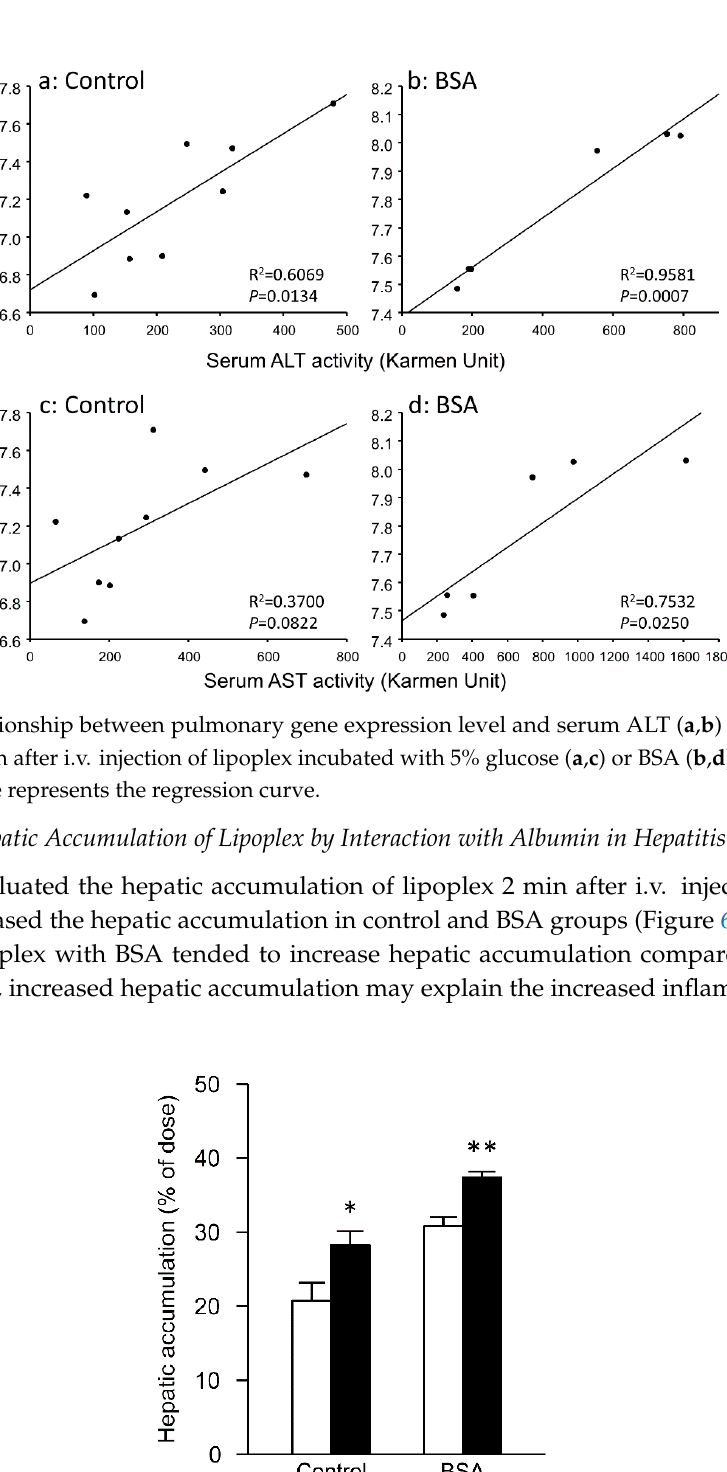
Figure 4. Relationship between hepatic gene expression level and serum ALT ( a , b ) or AST ( c , d ) activity level 6 h after i.v. injection of lipoplex incubated with 5% glucose ( a , c ) or BSA ( b , d ) in hepatitis mice. Solid line represents the regression curve.